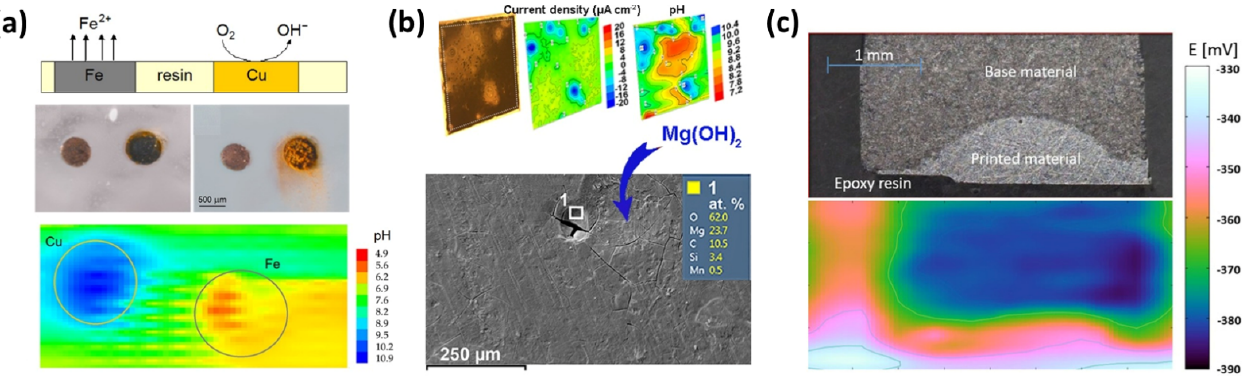
Figure 7. ( a ) Depiction of the galvanic corrosion process of a Cu-Fe pair and its associated local pH map. Adapted from ref. [97]. Copyright (2016) with permission from Elsevier. ( b ) Localized currents and pH maps accompanied with optical and SEM images of the MA8 Mg alloy after being exposed to MEM solution Adapted from reference [100]. Copyright (2020) with permission from Elsevier. ( c ) Distribution of pH at the 3D-printed plate/base material boundary exposed to corrosive medium. Reprinted from reference [63]. Copyright (2020) with permission from John Wiley and Sons.